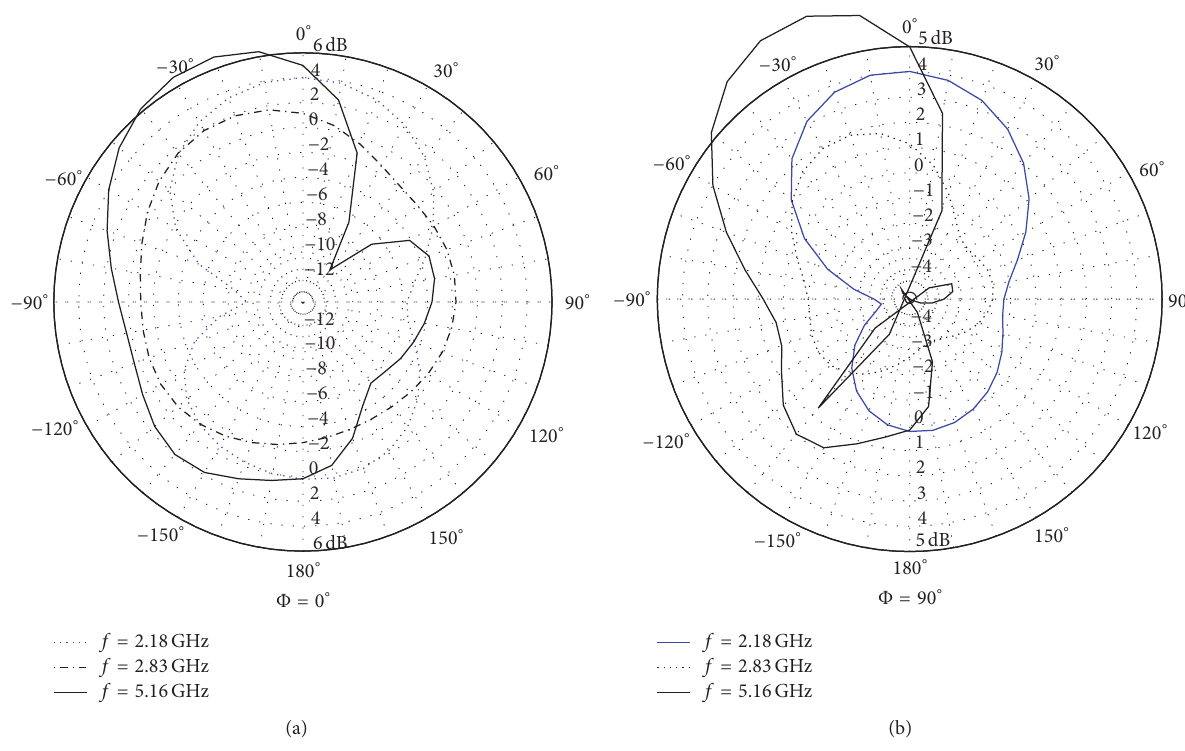
Figure 13: Simulated 2D radiation pattern for final PIFA